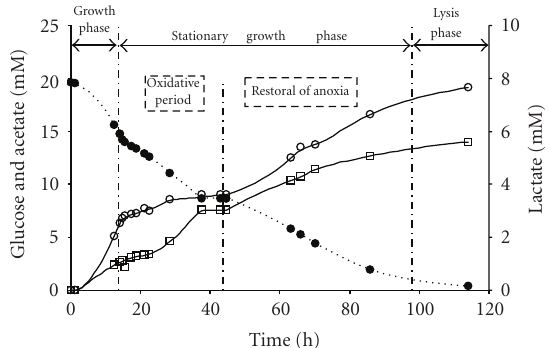
Figure 3: Fermentative parameters of Thermotoga maritima culti- vated in a bioreactor under anoxic conditions including oxidative ), acetate ( ), and lactate ( ). period: glucose ( (cid:0) (cid:2) (cid:3)